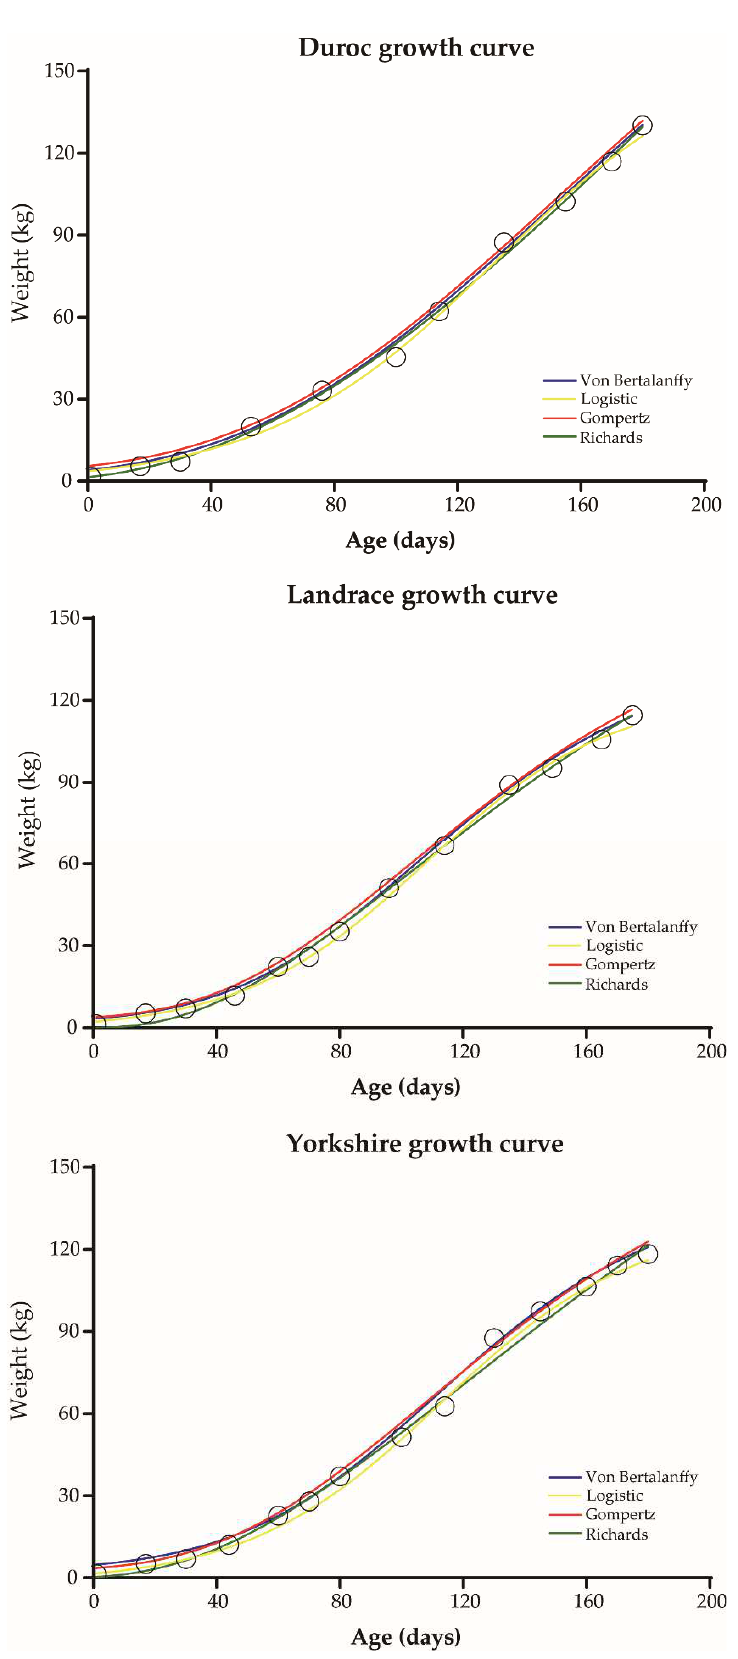
Figure 1. Fitted growth curves for Duroc, Landrace and Yorkshire pigs. The circle represents observed body weight. Lines in different colors indicate different growth curve models.